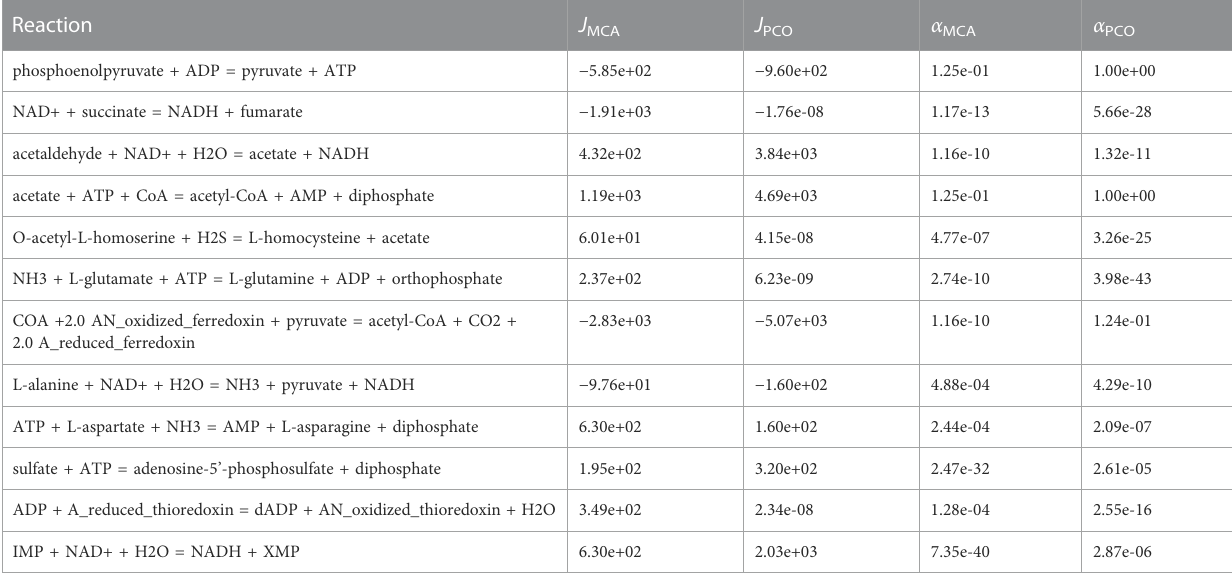
TABLE 1 Reactions regulated in the MCA approach in which the goal was to control concentrations. Ten out of twelve of these reactions are also regulated in the pathway-controlled optimization approach. Reaction